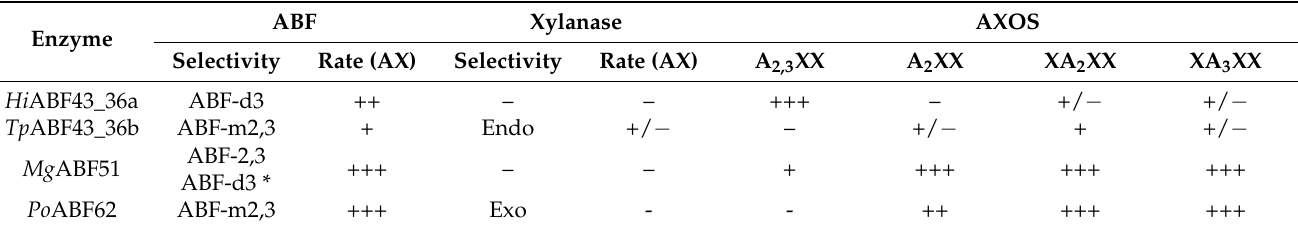
Table 2. Comparison of substrate selectivity and rate of arabinofuranosidase (ABF) and xylanase activity on AX and AXOS by Hi ABF43_36a, Tp ABF43_36b, Mg ABF51, and Po ABF62. +++